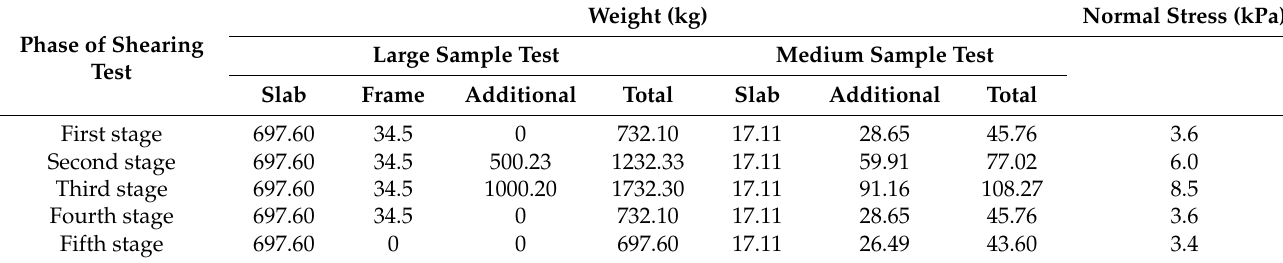
Table 2. Weight and normal stresses used in the large and medium